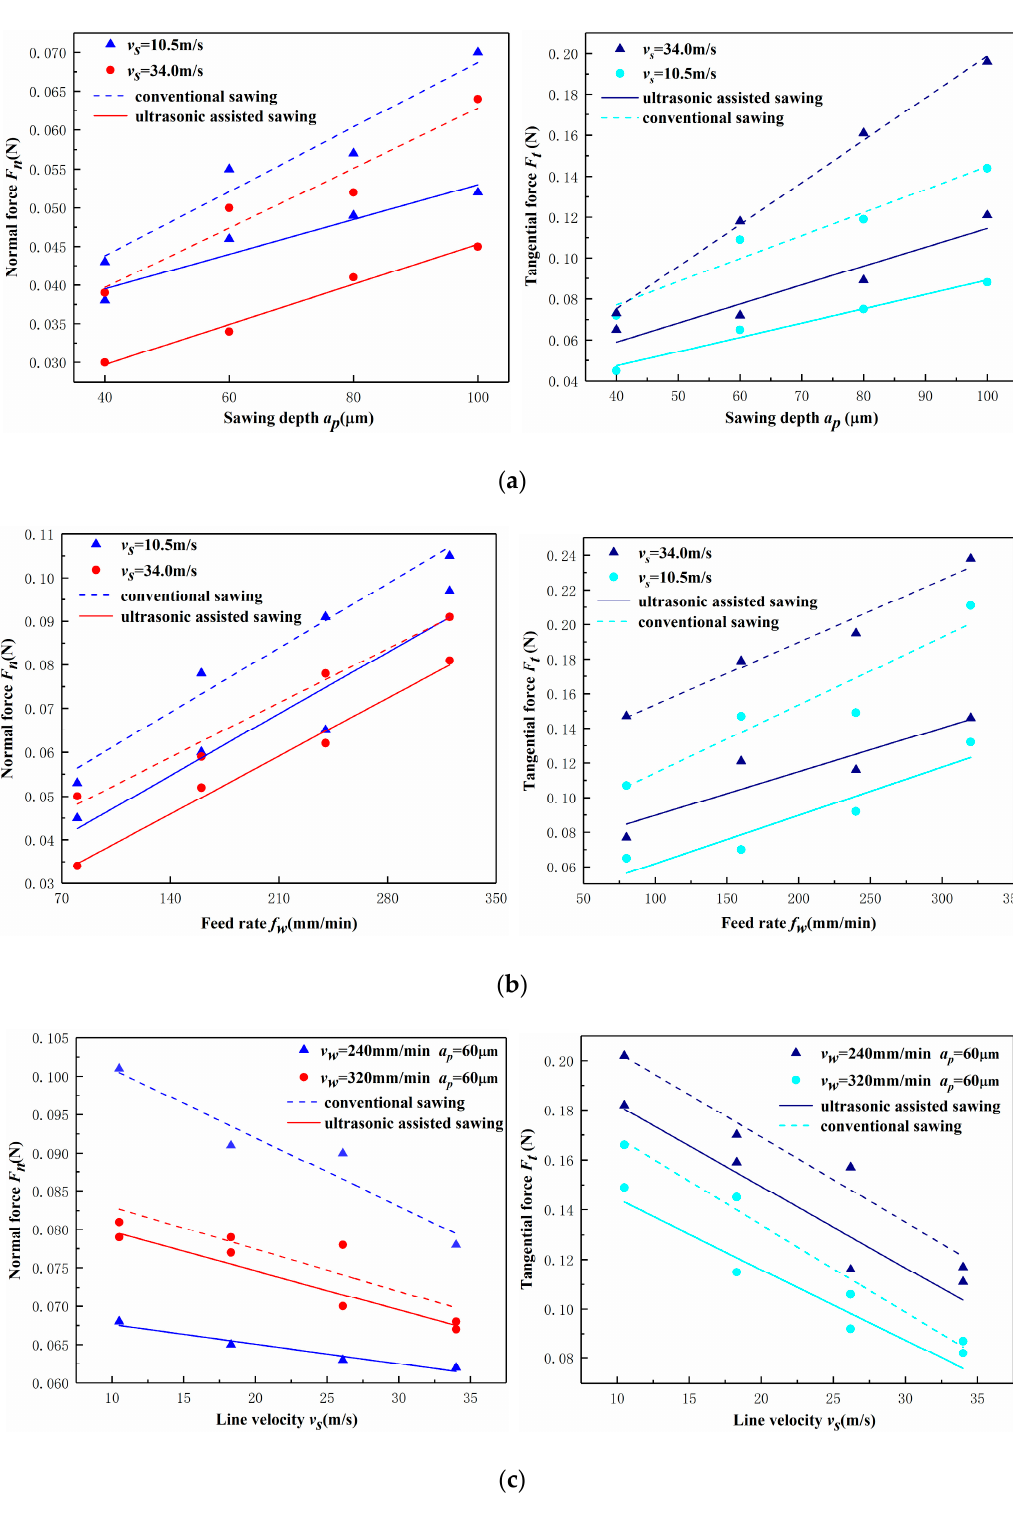
Figure 7. The impact force F m varying with machining parameters: ( a ) The impact force versus sawing depth ( v w = 80 mm/min); ( b ) The impact force versus feed rate ( a p = 60 μ m); ( c ) The impact force versus line velocity.